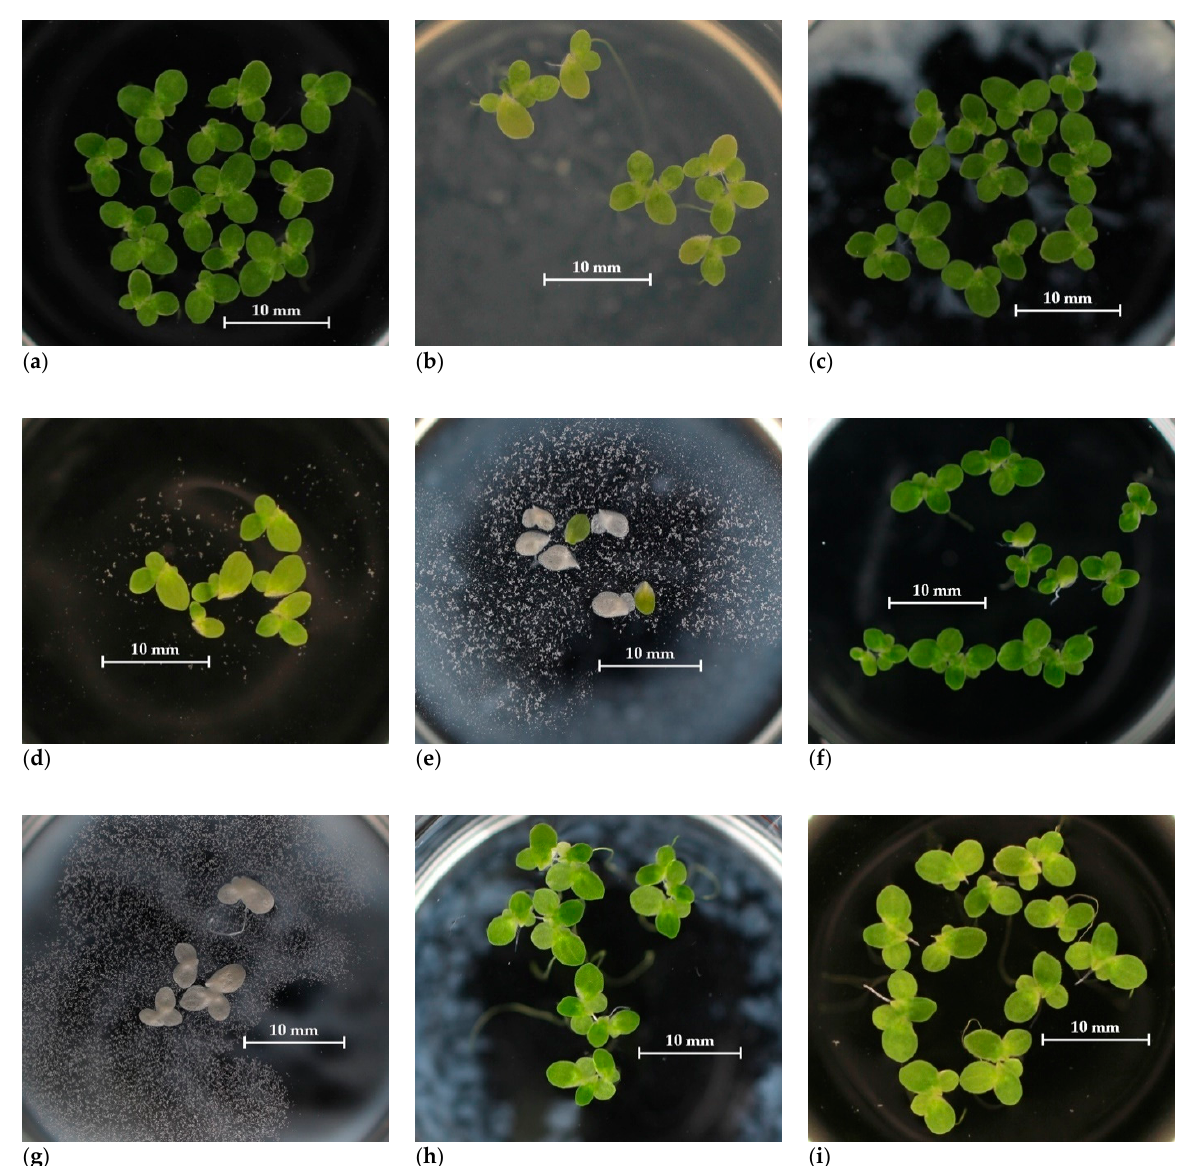
Figure 5. Test plants photo-documentation: ( a ) control, ( b ) NA—100%, ( c ) NA—salts, ( d ) RA 1—100%, ( e ) RA 2—12.5%, ( f ) RA 2—1.56%, ( g ) RA 3—100 + s, ( h ) RA 3—12.5 %, ( i ) RA 4—100%.